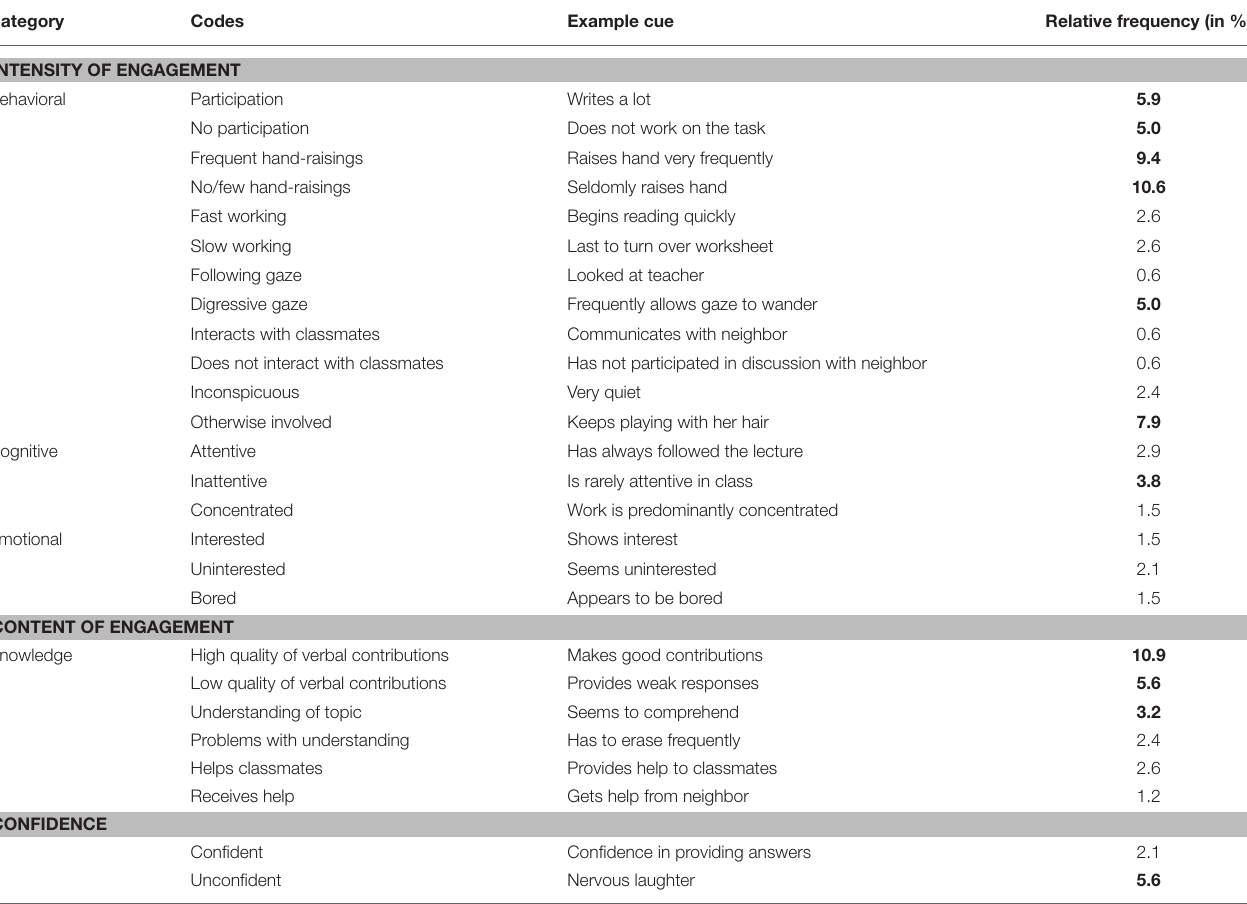
TABLE 1 | Coding scheme for student cues and their relative frequency. Category